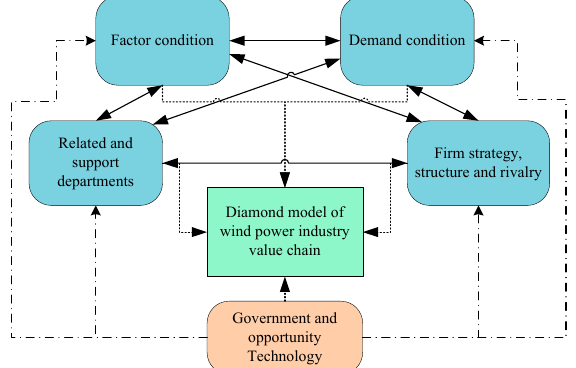
Figure 6. Diamond model of the wind power industry value chain